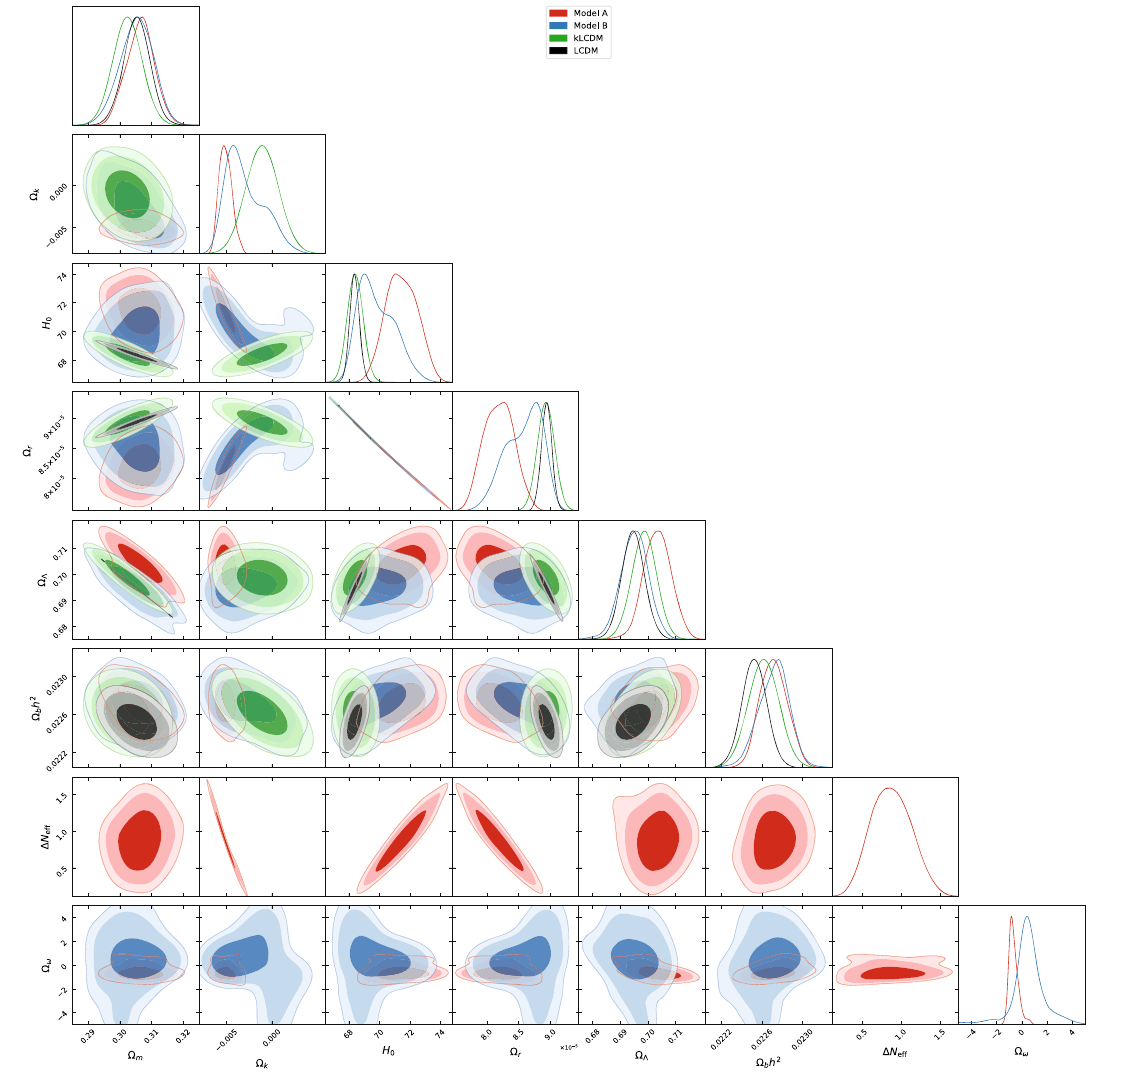
Fig. 4 2D joint and 1D marginalized posterior probability distributions for all the parameters in Table 1, obtained within the models A , B , LCDM, kLCDM. Contour plots are shown up to 3 σ ( 99 . 7% )